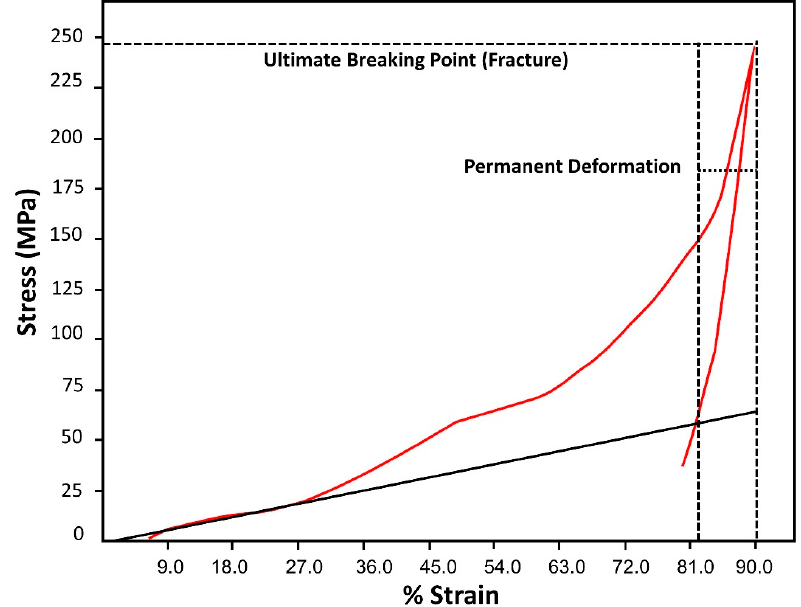
Figure 10. Compression test graph of phenol-furfural resin / organo modified MMT clay composite based high pressure composite by Tinius Olsen Press.